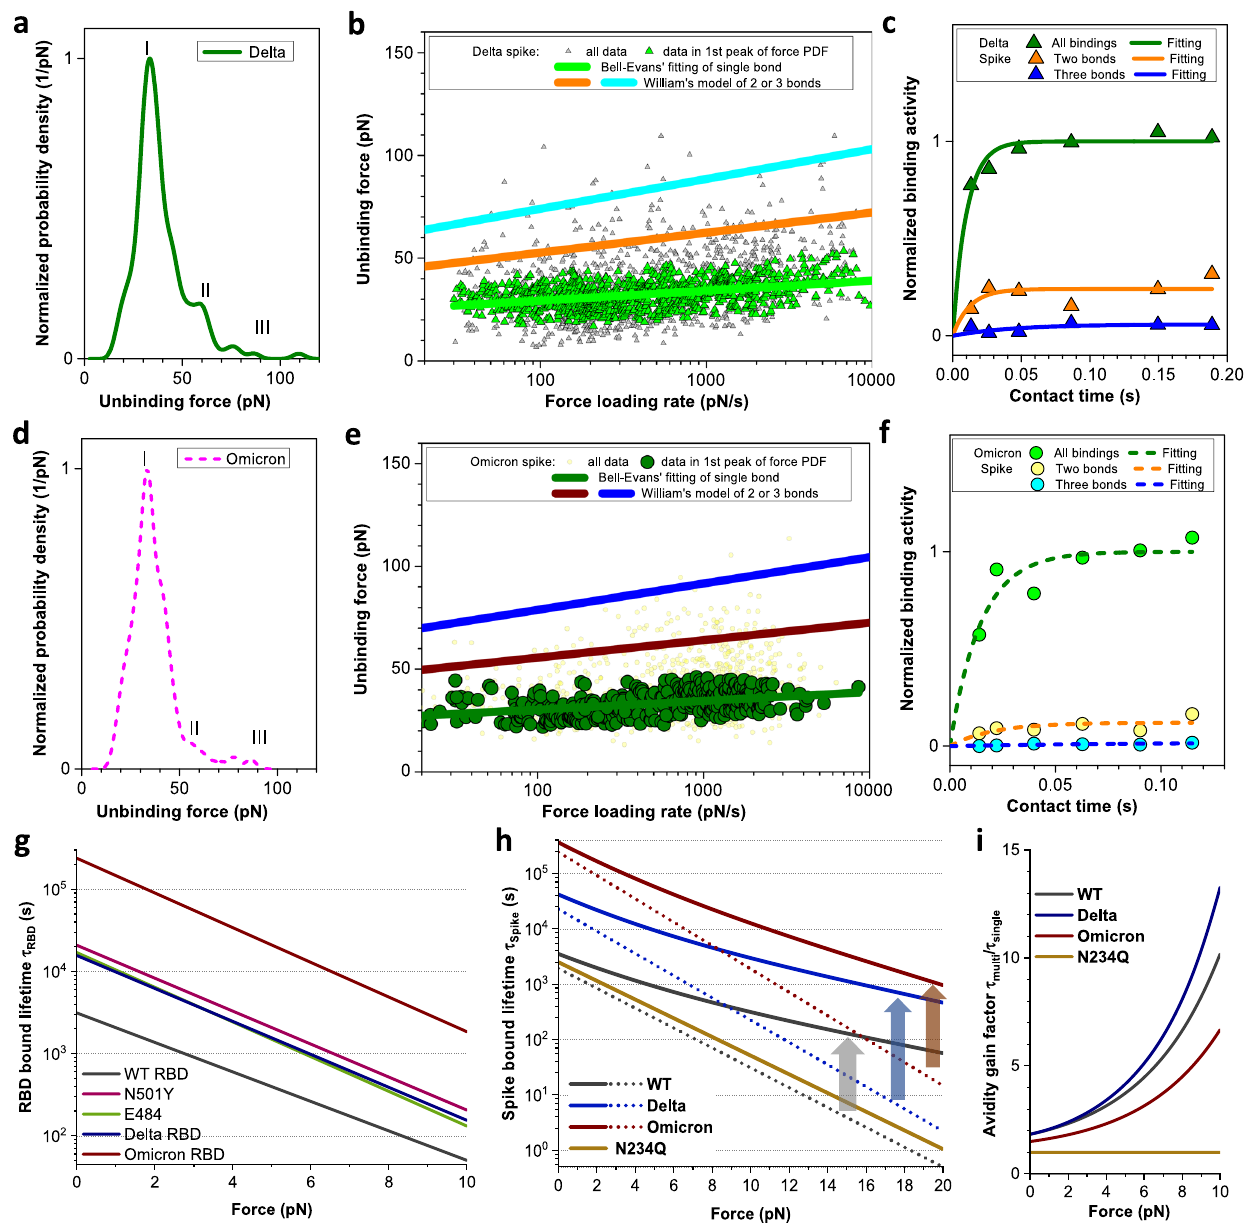
Fig. 5 | Mutations and avidity ampli fi cation lead to the prolongation of Spike binding to ACE2. a , d Experimental PDFs from measured dissociation forces betweenSpikeandACE2.ForcemaximafortheSpiketrimerDelta( a )andOmicron (B.1.1.529) ( d ) variants correspond to the simultaneous dissociation of one (I), two (II),orthree(III)bonds. b , e Dependenceofdissociationforcesontheforceloading rate.Dataofthe fi rstpeak( b ,greentrianglesforDeltavariantand e olivecirclesfor Omicron (B.1.1.529)) were fi tted with the Bell – Evans theory ( b , green line for Delta variantand e ,olivelineforOmicron(B.1.1.529)).TheMarkovbindingmodelfortwo and three bonds are computed and shown as orange and cyan lines for the Delta Spike ( b ) and wine and blue lines for Omicron (B.1.1.529) Spike ( e ), respectively. c , f Dependence of binding activity on contact time between AFM tip and cellular surfaces for the Delta Spike ( c olive triangle) and the Omicron (B.1.1.529) Spike ( f green circles). Ratioofforce curves containing two( c , orangetriangles for Delta